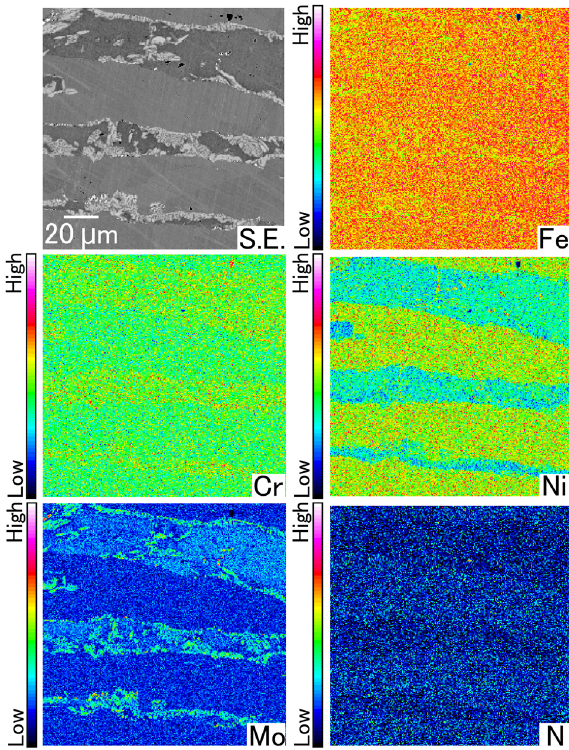
Fig. 4 SEM image and EPMA maps of the aged specimen. The observed and analyzed area was that demarcated by the dashed black square in Fig. 3.